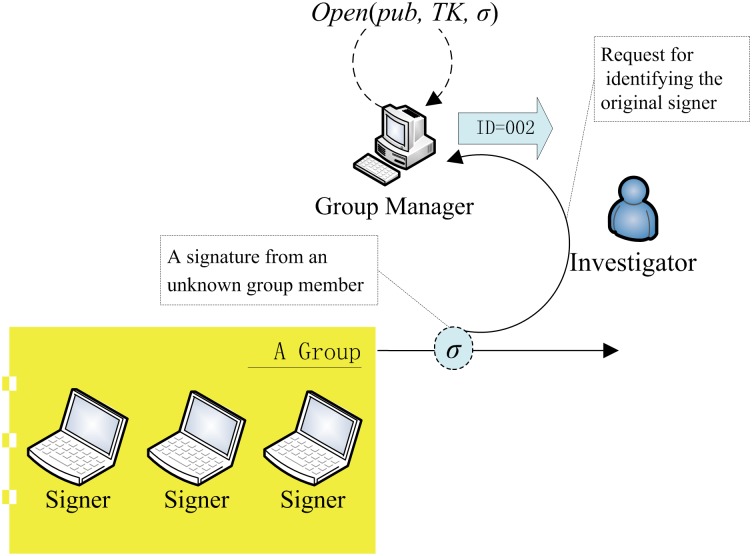
The usage of the Open algorithm.